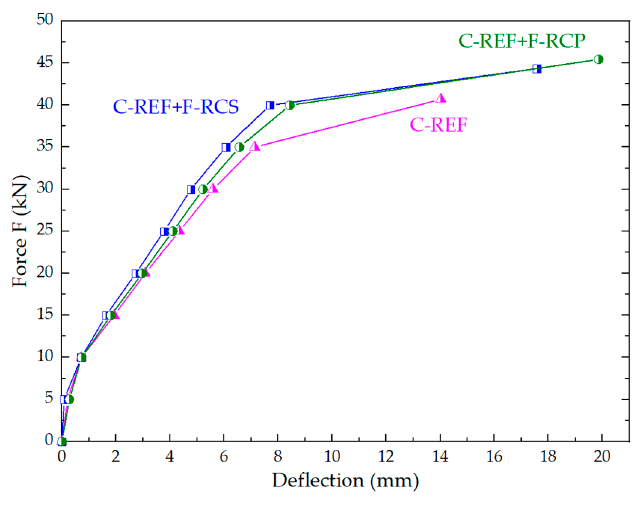
Figure 14. Comparison of the deflections of the tested slabs.